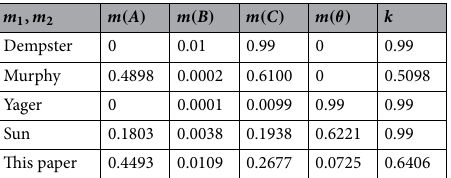
Table 3. The processing results of different algorithms for robustness problems.